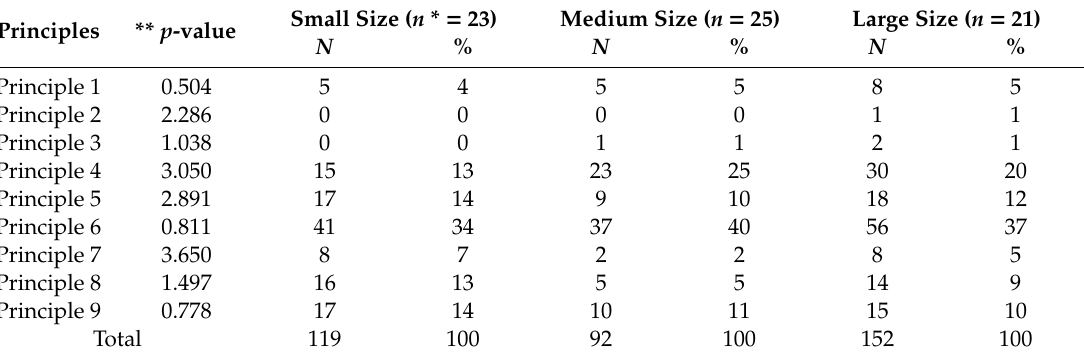
Table 5. The distribution of minor non-conformities (NCs) according to the size of leased forest area in 2015 ( n = 69).